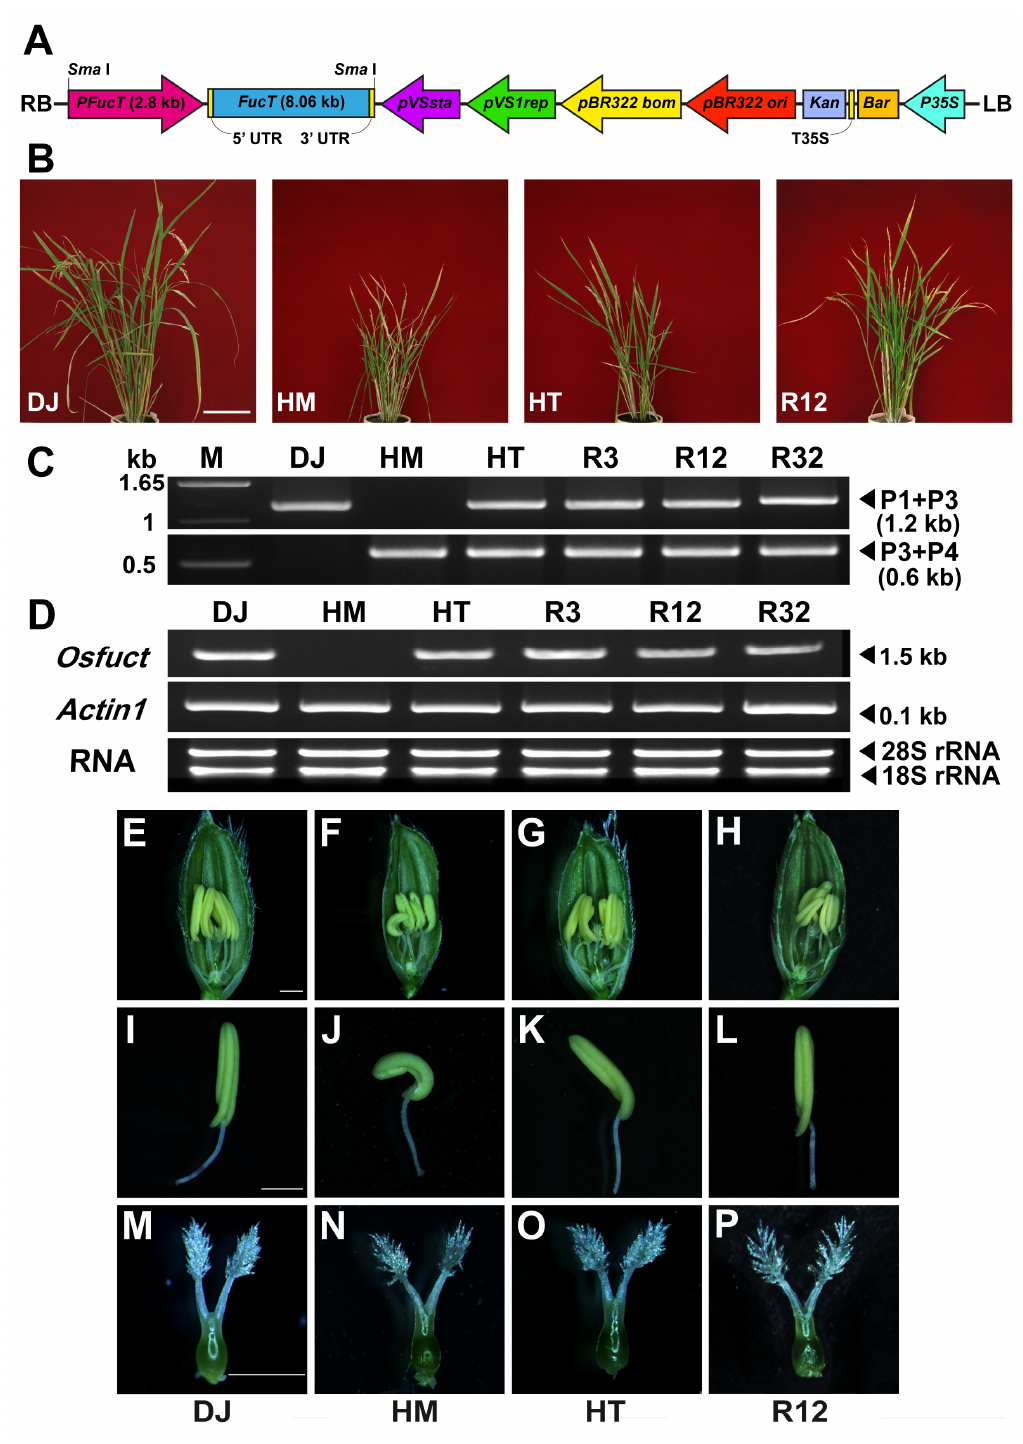
Figure 3. Generation of transgenic rice plants by over-expressing entire Osfuct gene in the HM mutant to confirm complementation. ( A ) Diagrammatic representation of the pCAMBIA3300 construct used for Osfuct transformation. RB, right border; FucT, entire Osfuct gene including the 2852-bp upstream sequence, and the 8066-bp downstream sequence; pVSsta and pVS1rep, neomycin phosphotransferase gene; pBR322 bom and ori ; Kan, kanamycin resistance gene; Bar, phosphinothricin resistance gene; LB T35S, terminator of the 35S gene; P FucT , Osfuct promoter, LB, left border sequence. ( B ) Morphological phenotype of restored lines (R3, R12, and R32) compared with the DJ, HM and HT lines. Scale bar is 17 cm. ( C ) Genotyping of restored lines (R3, R12, and R32) compared with the DJ, HM and HT lines. Gene specific (P1, P2, and P3) and T-DNA border sequence primer (P4) used for genotyping. The upper lane PCR products were amplified using gene-specific primers P1 and P3 (1.2 kb), while the lower lane PCR products were amplified using the P3 gene-specific primer and T-DNA border sequence primer P4 (0.6 kb). ( D ) Expression analysis of the Osfuct transcript in the rescued lines (R3, R12, and R32) compared with the DJ, HM and HT lines using RT–PCR. The expression level of actin1 was used as a loading control and gene specific primers (P5 and P6) were used for the RT–PCR analysis. ( E – L ) Comparison of anther phenotypes among the DJ, HM, HT and restored lines (R12), respectively. ( M – P ) Comparison of pistil phenotypes among the DJ, HM, HT and restored lines (R12), respectively. Scale bar is 1 mm.